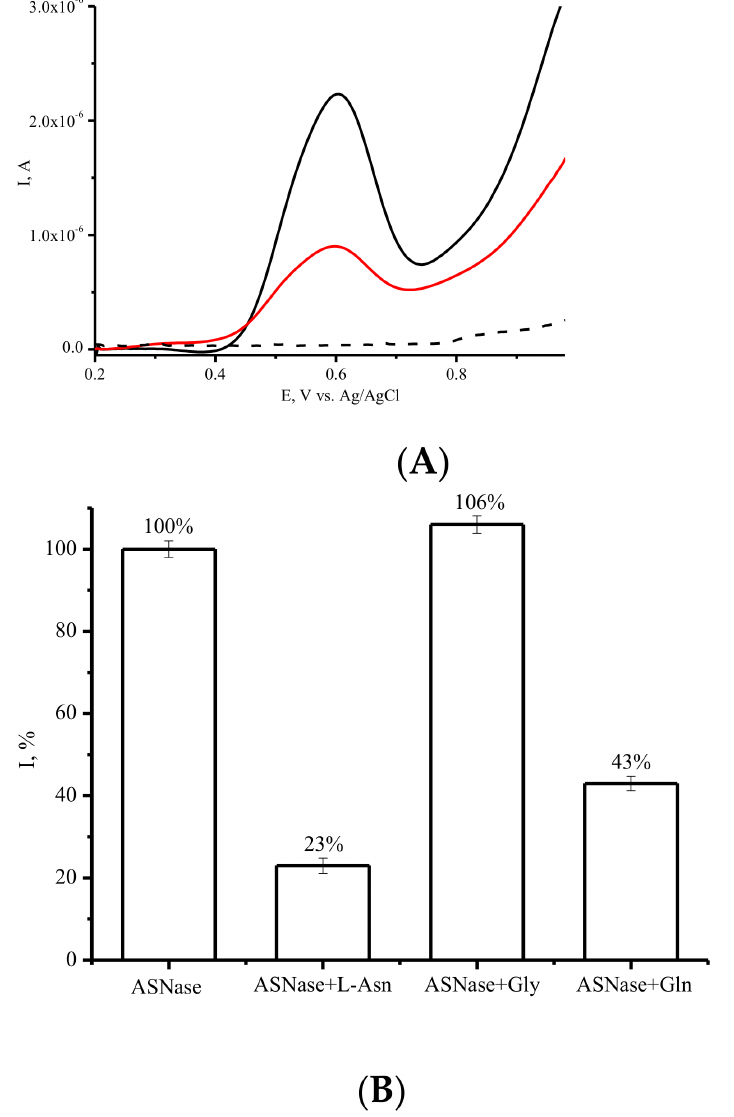
Figure 4. ( A ) DPV electrochemical oxidation signals of SPE/SWCNT/ASNase (-), SPE/SWCNT/ASNase after interaction with 33 mM Asn (-), SPE/SWCNT (—). ( B ) His- tograms corresponding to the average ASNase signals on SPE/SWCNT and ASNase on SPE/SWCNT after interaction with 33 mM L-Asn, after interaction with 33 mM Gly, after interaction with 33 mM L-Gln. Supporting electrolyte: 0.1 M potassium-phosphate buffer containing 0.05 M NaCl, pH 7.4. Table 1. Data from the differential pulse voltammetric (DPV) measurements of ASNase and ASNase after incubation with L-Asn, L-Gln, or Gly at SPE/SWCNTs ( n =